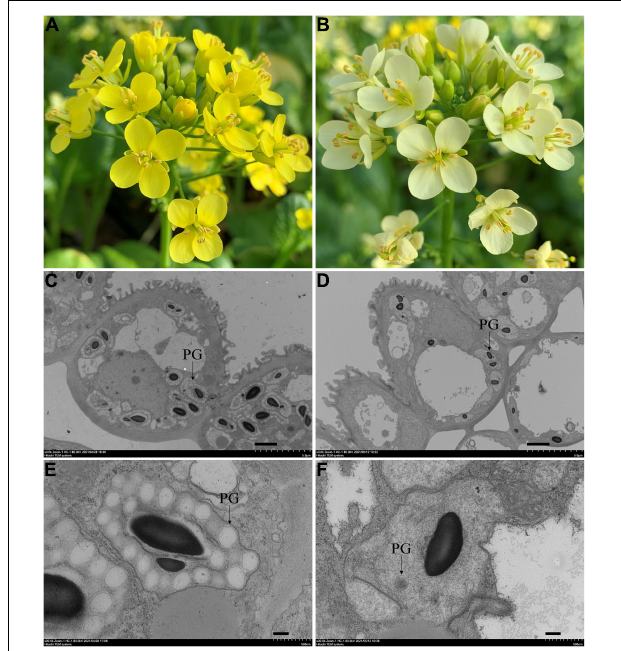
FIGURE 1 | Phenotypes of the yellow and pale-yellow flowering Chinese cabbage petals. Yellow (A) and pale-yellow flower petals (B) . Plastid morphology in the yellow (C,E) and pale-yellow petals (D,F) was compared by TEM analysis. Enlarged images are also shown (E,F) . PG: plastoglobules. Scale bars: (C,D) 2 µ m, (E,F) 200 nm.